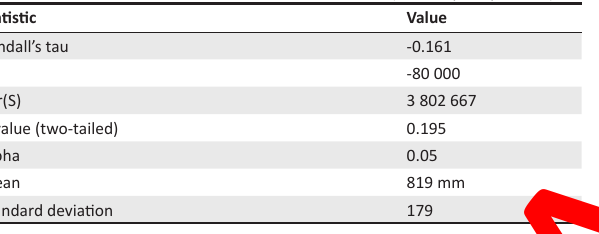
FIGURE 3: Annual rainfall trend for Eswatini (1986–2017). TABLE 4: Mann–Kendall trend test and two-tailed test (annual precipitation).